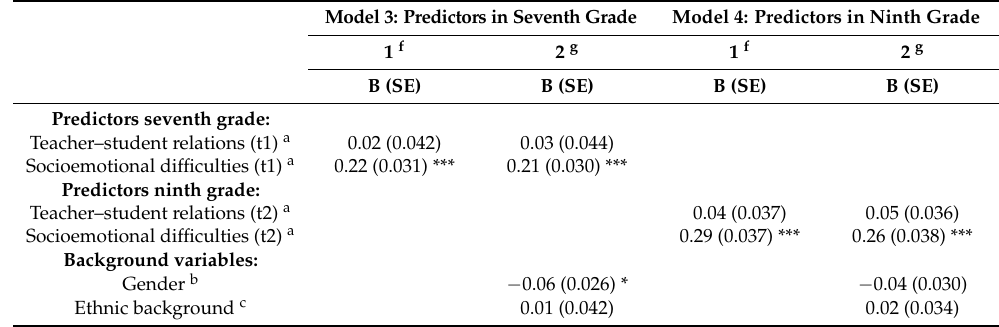
Figure 2. Unstandardized regression coefficients of latent change factor model: IA-related symptoms on psychosocial predictors and asthma/allergy variable ( N = 986). Standardized values in parentheses. Dashed lines represent non-significant associations. * Fixed factors. Table 4. Standardized regression coefficients and standard errors of linear regression Models 3 and 4 ( N = 978–986). The outcome variable is IA-related